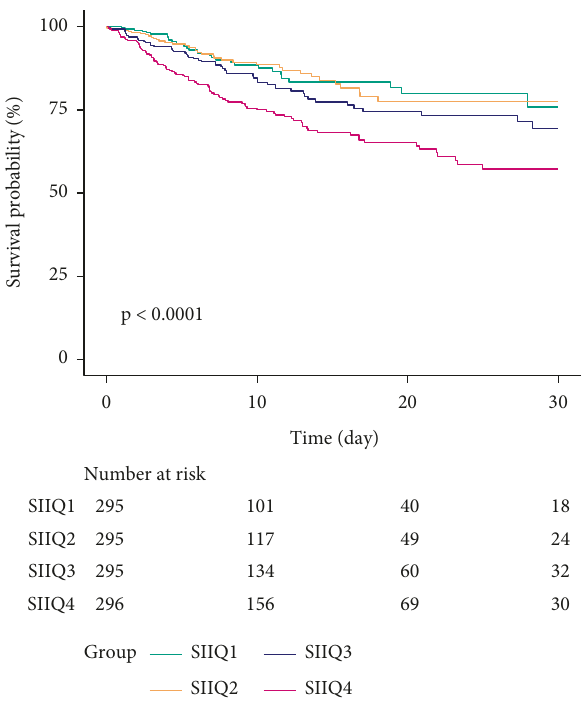
Figure 2: Kaplan–Meier survival curve for quartiles of SII.